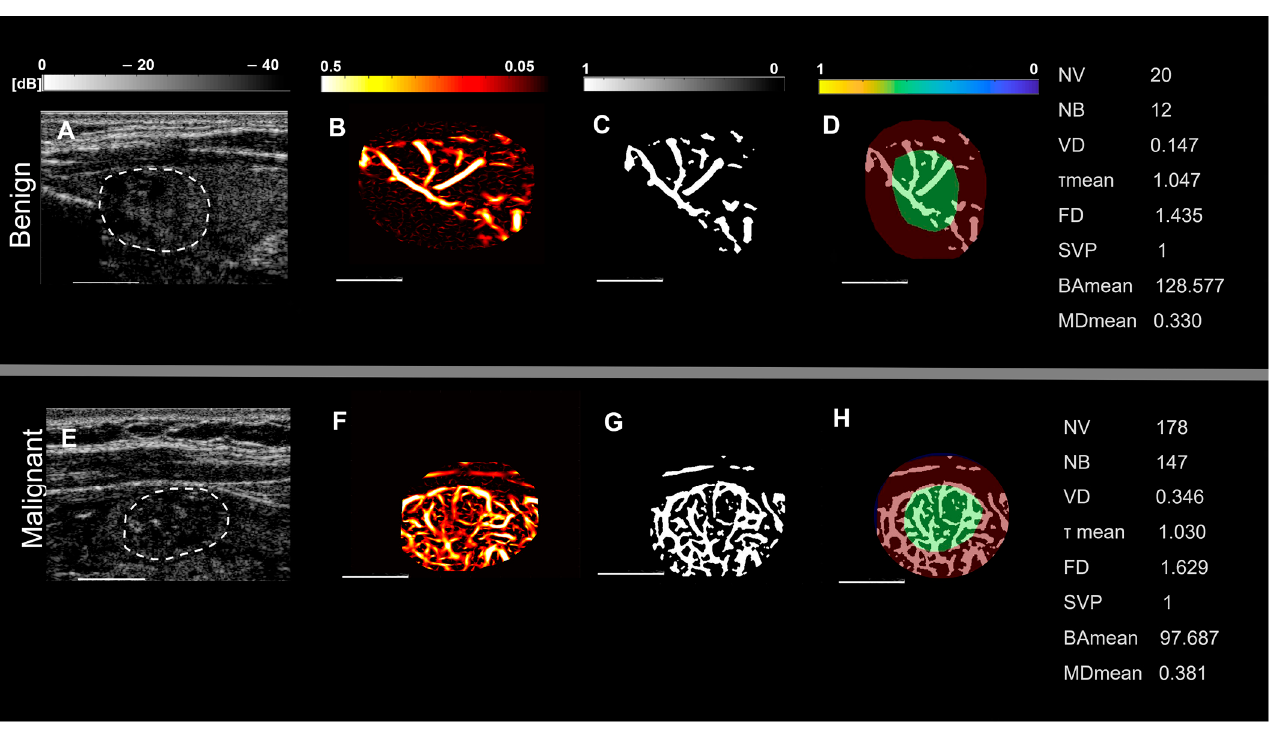
Figure 2. Representative images of small thyroid nodules < 20 mm, benign (top row) and malignant (bottom row). ( A , E ) are B-mode ultrasound images (dashed white circles delineate the boundaries of the nodules), ( B , F ) HDMI images, showing tumor microvessels, ( C , G ) are binary images of microvessels, ( D , H ) spatial vascularity pattern (SVP) diagrams, (green circles represent the central region and the red ones the peripheral region of the nodule). The correspondent quantitative biomarkers are displayed on the right side of each row. The white line denotes a scale of 1 cm. Table 2. Summary of HDMI biomarker distributions for benign and malignant thyroid nodules and their corresponding p